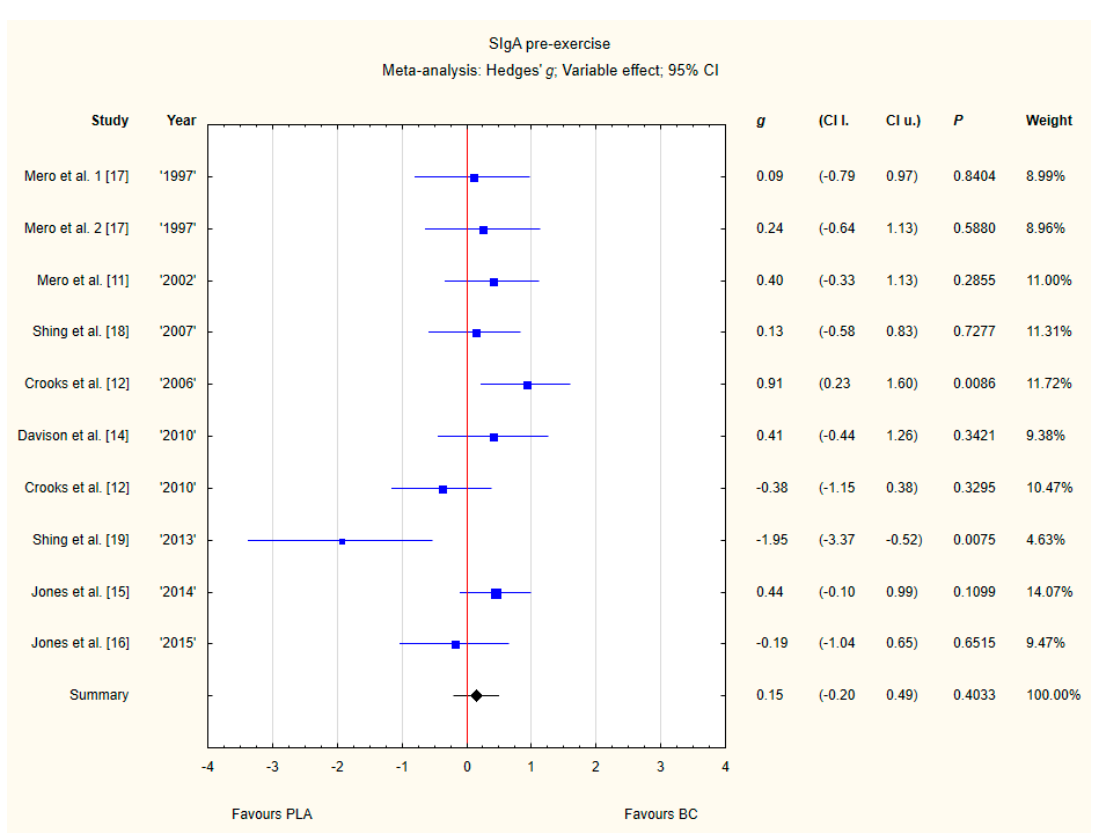
Figure 8. Forest plot of the random-effects meta-analysis of changes in pre-exercise SIgA concentration. Heterogeneity: Tau 2 = 0.15; Chi 2 = 17.35; df = 9; I 2 = 48.13%; P = 0.0435. 1–the first dose